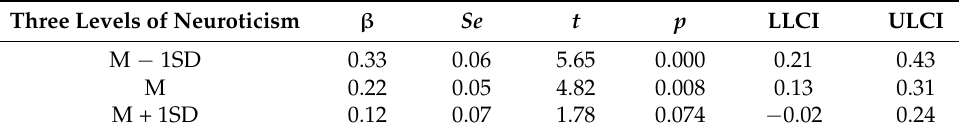
Table 4. Conditional effects of CP on SoC at three levels of